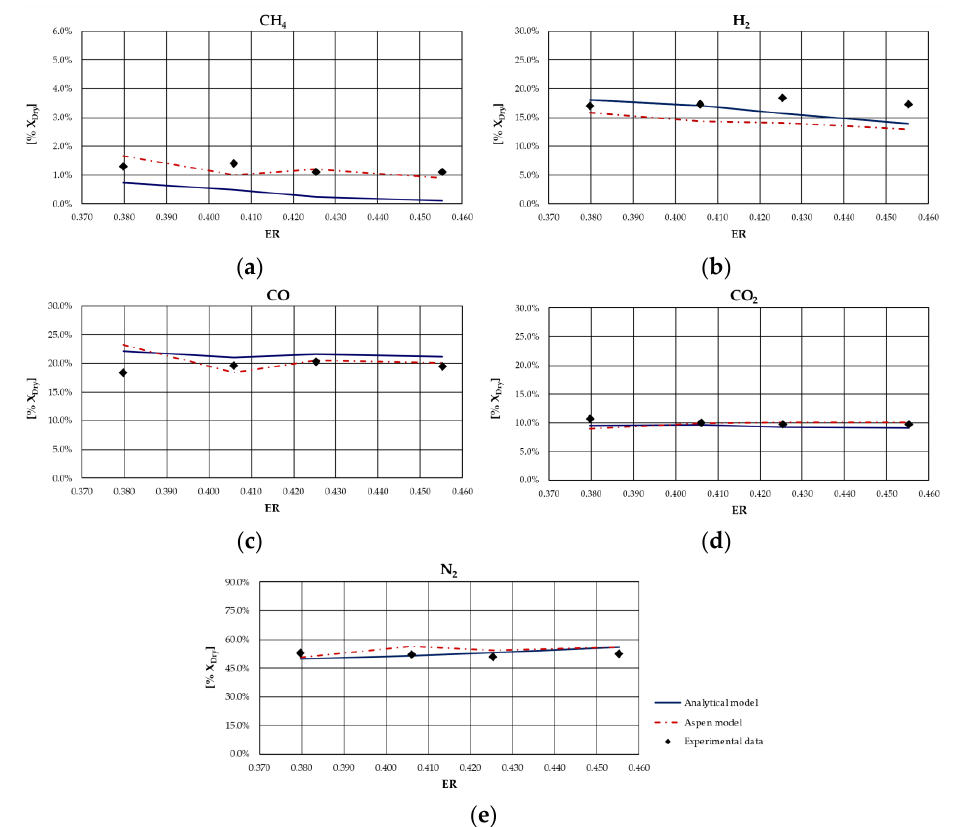
Figure 3. Comparison of average gasification bed temperature between analytical model results and experimental data from hazelnut shell [66].